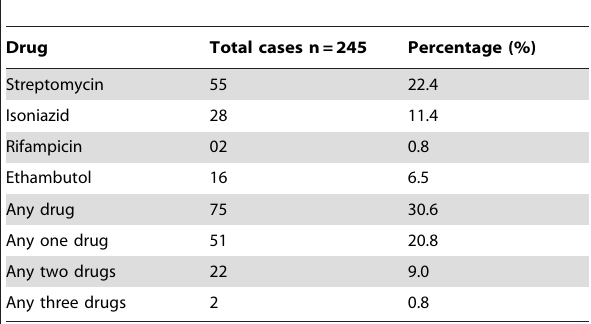
Table 1. Anti tuberculosis drug resistance pattern